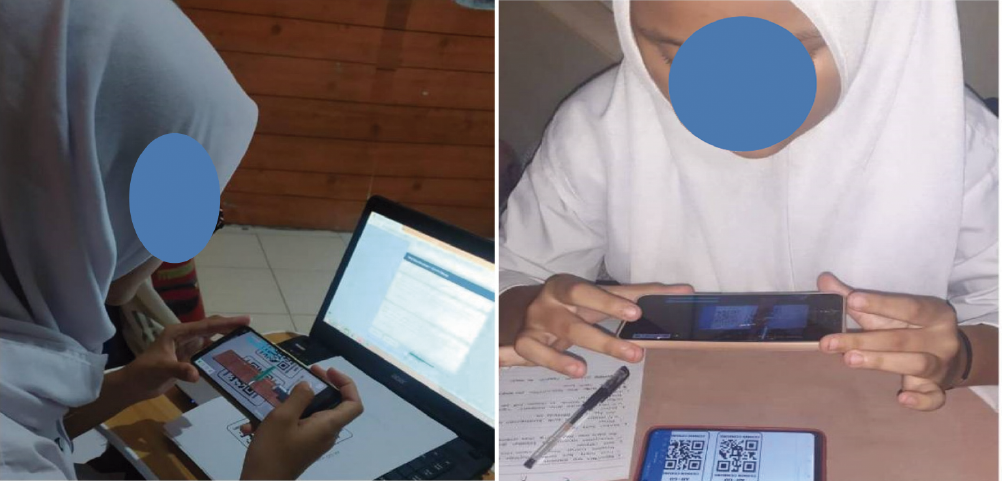
Figure 8. Students of MPIL learning